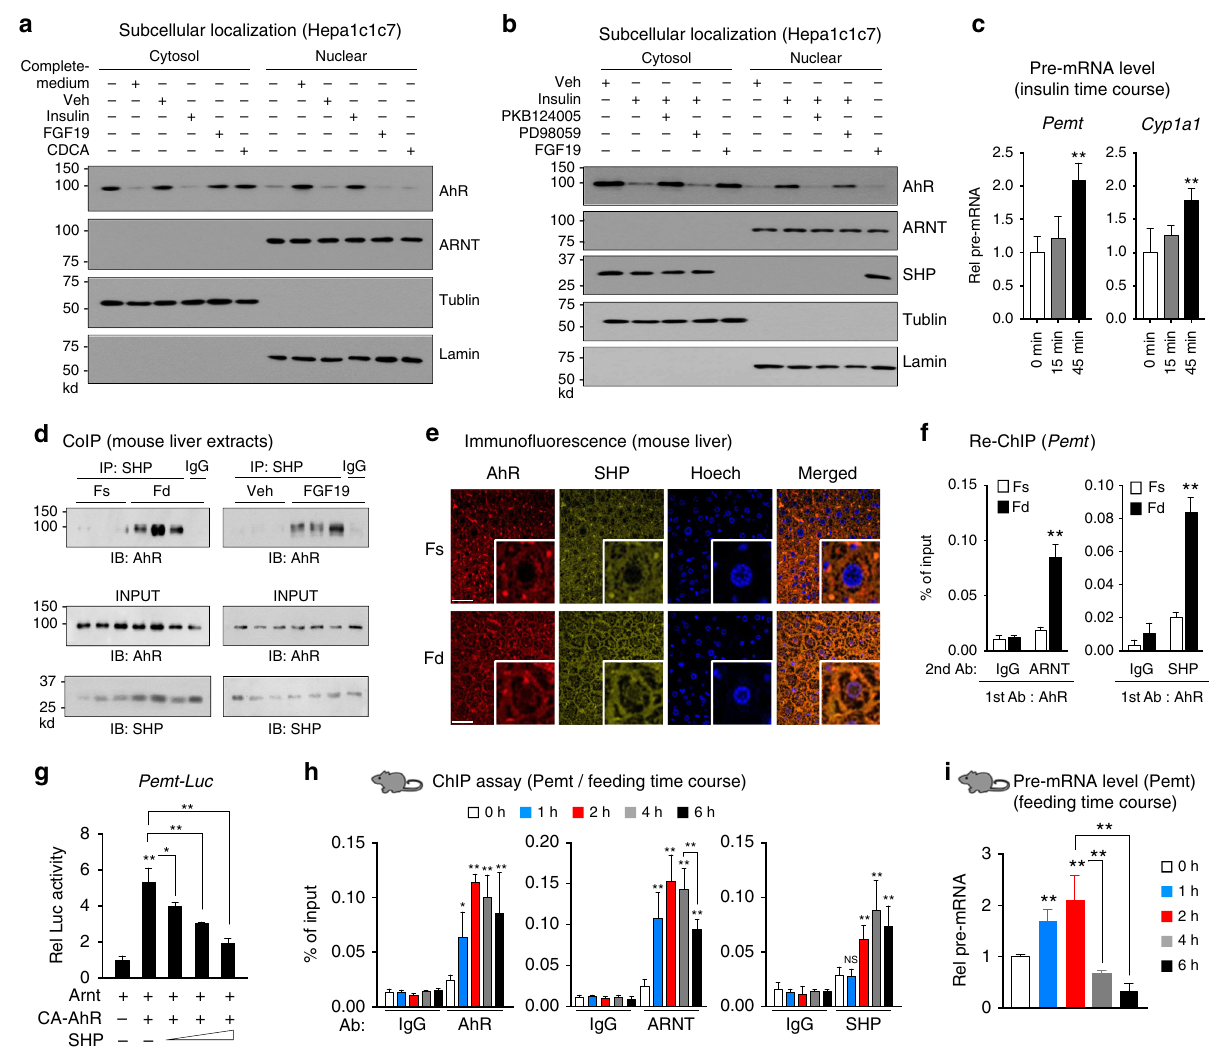
Fig. 4 SHP inhibits AhR transactivation of Pemt in response to feeding or FGF19 treatment. a , b Hepa1c1c7 cells were grown in low-glucose and serum-free media for 12 h, and transferred for 15 min to complete medium or treated for 15 min with insulin, FGF19, or CDCA, and then cells were harvested. Cells were pre-treated with a PKB inhibitor, PKB124005, or an ERK inhibitor, PD98059, for 30 min prior to insulin treatment as indicated. Levels of AhR and SHP in the cytoplasmic and nuclear fractions were determined by IB. Consistent results were observed from two independent studies. Full size immunoblots are in Supplementary Figure 12a. c Hepa1c1c7 cells were treated with insulin for 15 min or 45 min, and pre-mRNA levels of Pemt and Cyp1a1 were measured ( n = 6). d Mice were fasted for 12 h (Fs) or fasted and refed for 4 h (Fd) or fasted 4 h and treated with FGF19 for 2 h, liver nuclear extracts were prepared, and the interaction of SHP and AhR was examined by CoIP. e , f Mice were fasted overnight (Fs) or fasted and refed for 6 h (Fd). e Cellular localization of AhR and SHP in mouse liver sections was examined by IF. Scale bar: 100 µ M. f Liver chromatin was immunoprecipitated with AhR antibody, then eluted, and re-precipitated with ARNT or SHP antibody to examine the occupancy of SHP at AhR-bound chromatin at the Pemt promoter ( n = 5 mice). g Hepa1c1c7 cells were transfected with the indicated plasmids, and then treated with FGF19 for 2 h and luciferase activity was determined ( n = 5). h , i Mice ( n = 5 mice per group) were fasted for 12 h and then refed for the indicated times, and the occupancy of AhR, ARNT, and SHP at the Pemt promoter ( h ) or Pemt pre- mRNA levels ( i ) were determined by liver ChIP assay or by qRT-PCR, respectively. Means ± SD are shown, and statistical signi fi cance was measured using the c , g , i one- or f , h two-way ANOVA with the FDR post-test. * P < 0.05, ** P < 0.01, NS, statistically not signi fi